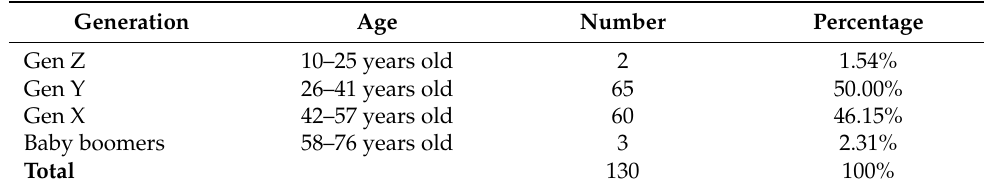
Table 2. Age generation of survey